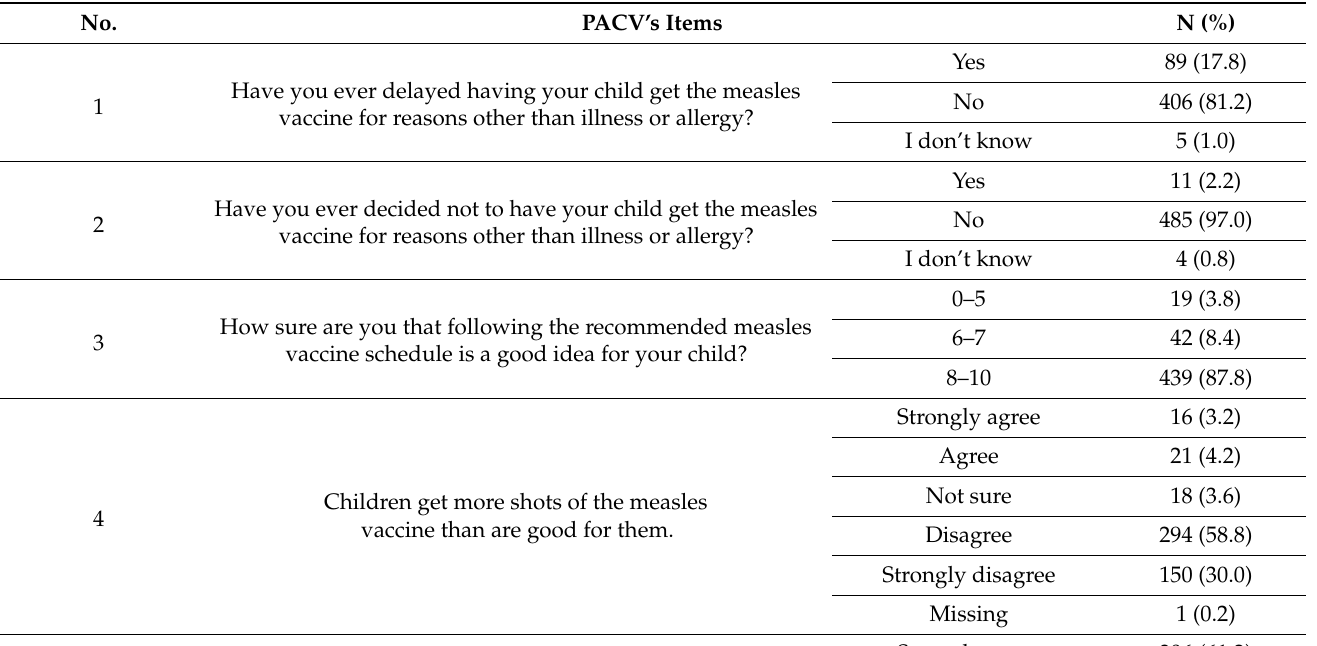
Table A1. Frequency Distribution of the 15 PACV Items (N =